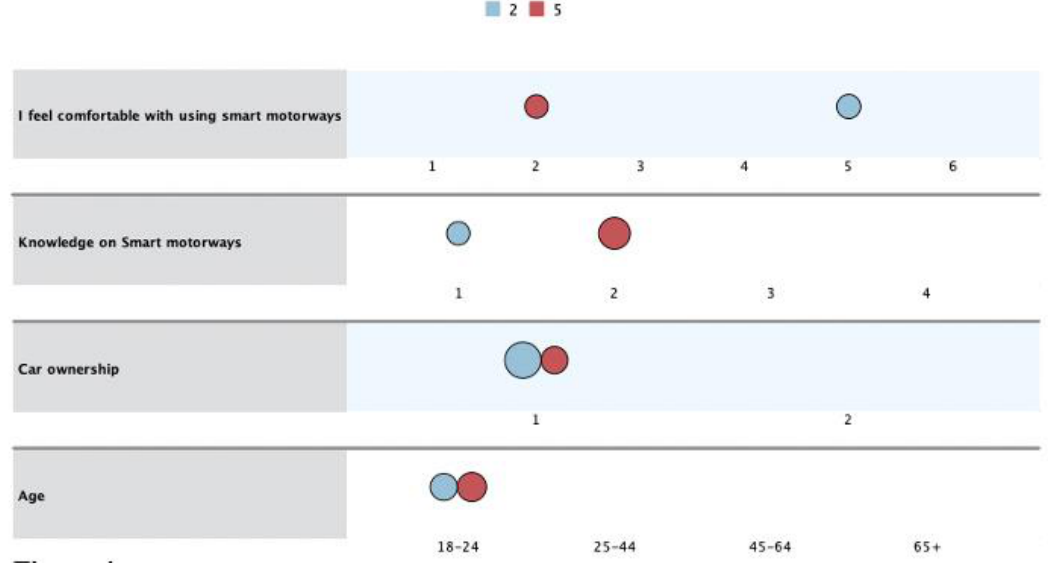
Figure 4 Higher knowledge of Smart Motorways and